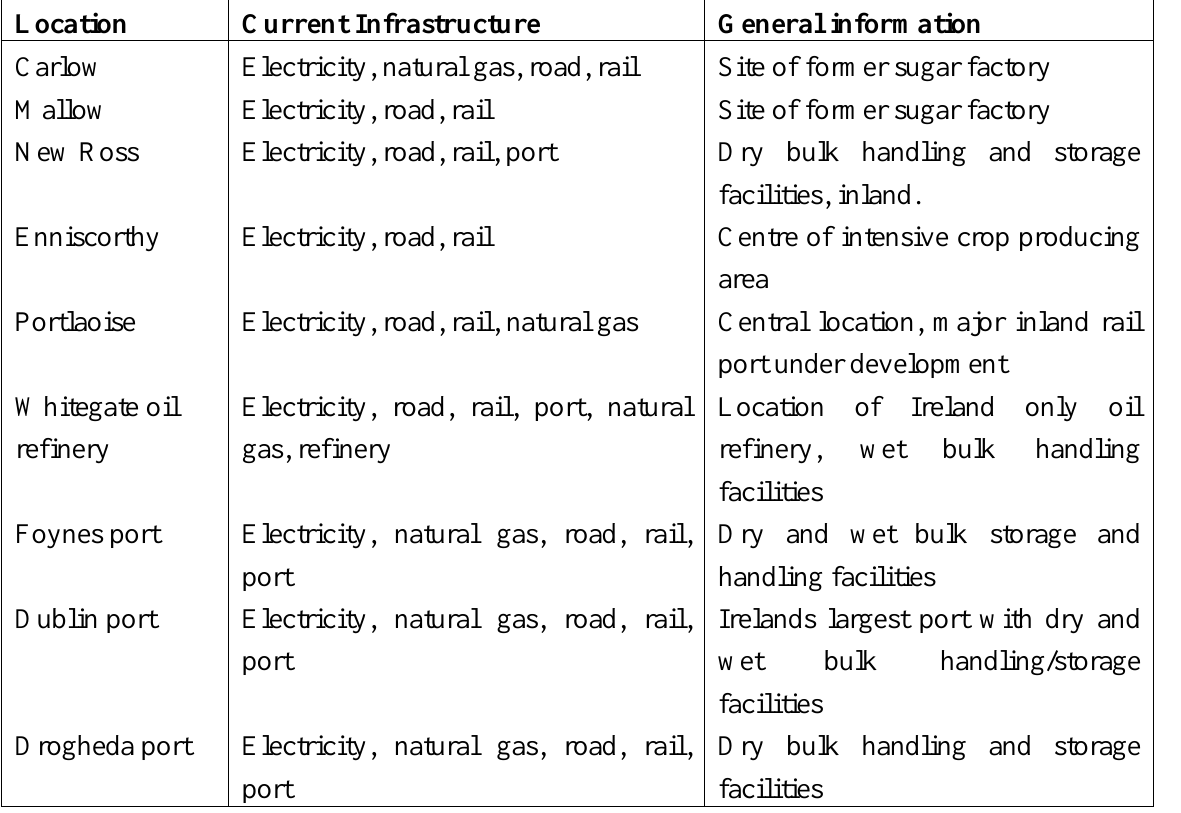
Table 1. Potential bioethanol plant locations, currently available infrastructure and general information.